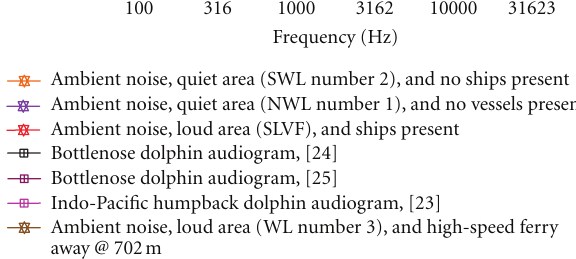
Figure 2: Ambient sounds of the four areas varying in general ship tra ffi c and types of ships present. Bottlenose and humpback dolphin audiograms show the magnitudinal di ff erence between vessel sounds and minimum audible levels for the dolphins. Southwest Lantau number 2 (SWL number 2) is between the Soko Islands with very little boat tra ffi c and a Beaufort sea state (Bss) of 3. Likewise, Northwest Lantau number 1 (NWL number 1) is described as having very little boat tra ffi c, located within the Sha Chau and Lung Kwu Chau Marine Park, recorded during a Bss of 3. West Lantau number 3 (WL number 3) is within the very busy shipping route at South Lantau Vessel Fairway with a high-speed ferry away at 702 m, Bss 3. South Lantau Vessel Fairway (SLVF) was recorded with several ferries and a shrimp trawler present during a Beaufort sea state of